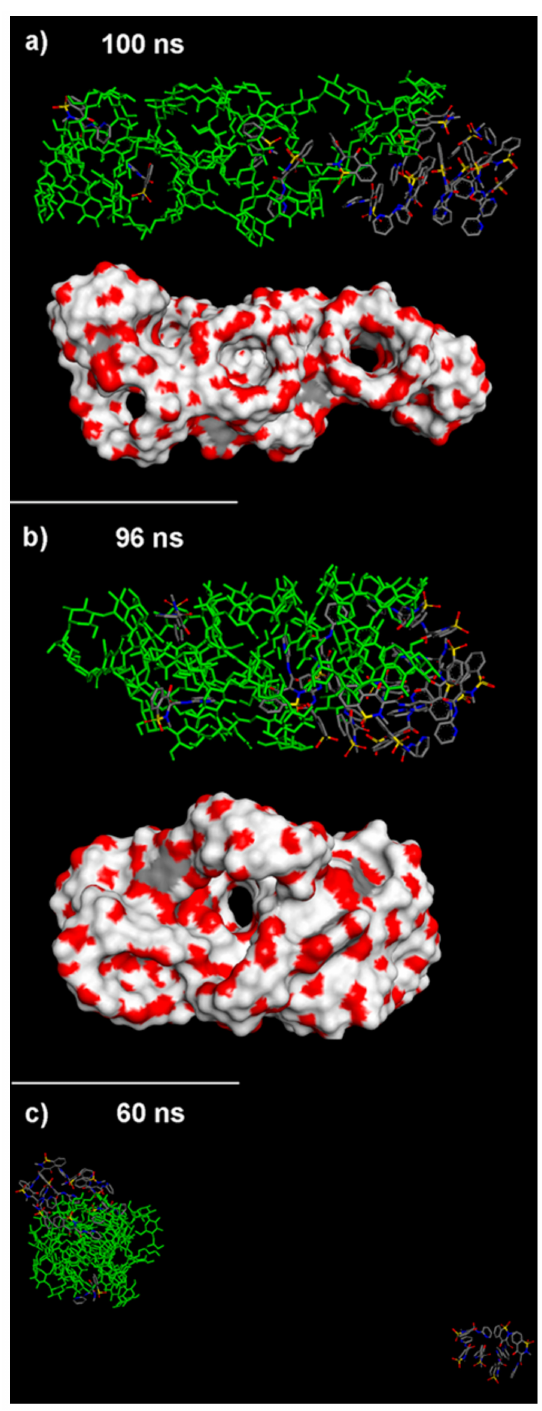
Figure 10. Panel ( a ) shows the optimized geometry assumed by the NS / 16 PX drug molecules system at the end of the MD run lasting 100 ns and panel ( b ) displays the optimized geometry assumed by the system at 96 ns. In the top part of each panel the NS is in green for clarity and the PX molecules are colored according to the color codes of Figure 3, and in the bottom part, the solvent-accessible surface area without the PX molecules is reported for clarity (see the color codes in Figure 5). Panel ( c ) shows the geometry assumed by the system at 60